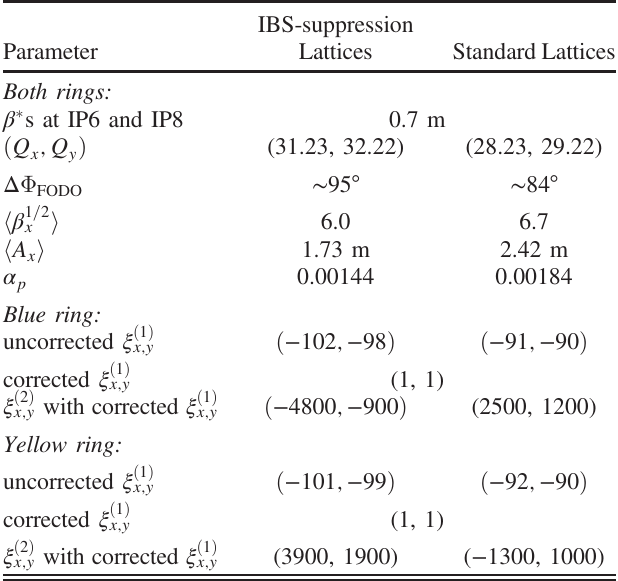
Table I shows the lattice parameters based on off-line optics models for both lattices. Δ Φ is the phase FODO advance per FODO cell, α the momentum compaction p ð 1 Þ ξ ð 2 Þ factor. ξ x;y and x;y are the first and second order chroma- ticities. For comparison, β (cid:2) s at IP6 and IP8 are set to 0.7 m for both lattices. The IBS-suppression lattice was